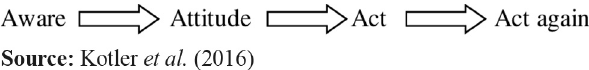
Figure 4. Derek Rucker ’ s 4A hierarchy of communication